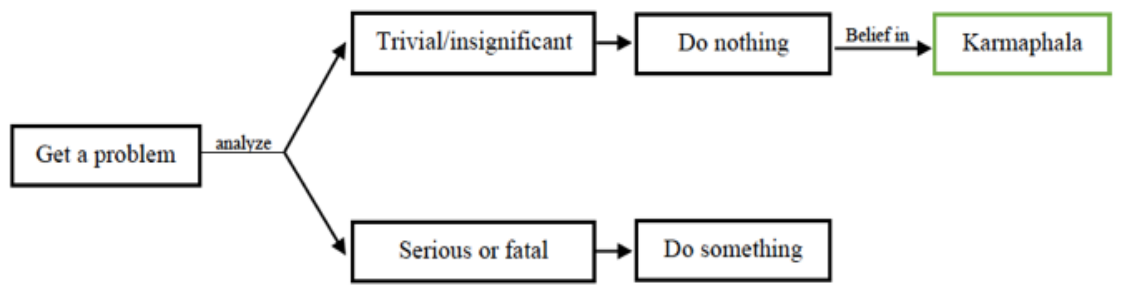
Fig. 4 Implementation process of Karmaphala value in Third Informant’s problem solving